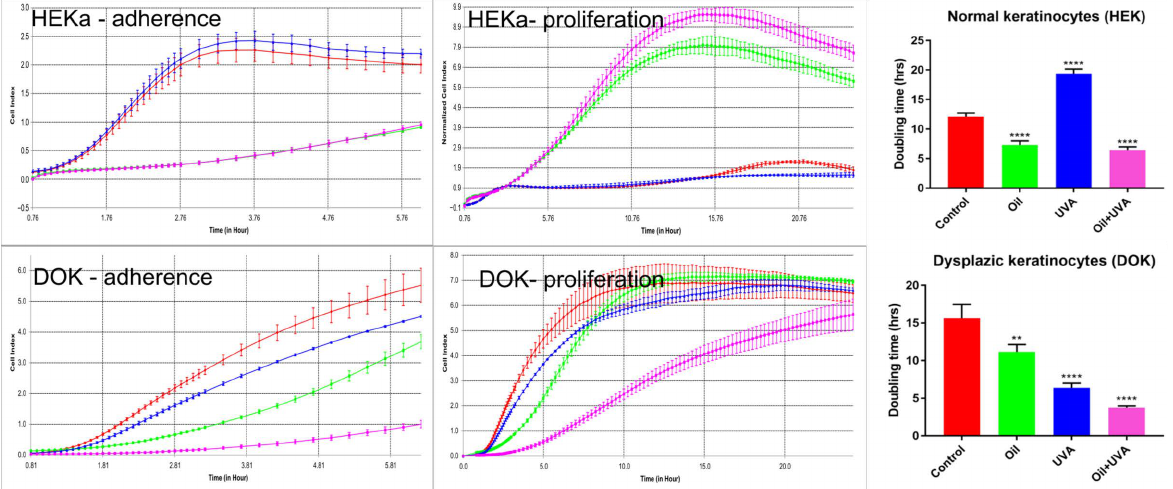
Figure 4. Cell adhesion and proliferation of normal and dysplastic keratinocytes, treated with sea-buckthorn seed oil, in the presence or absence of UVA irradiation. Each point on graphs represents the average cell index of triplicates, recorded every 15 min for 24 h. Bars represent average of triplicates with SD. One-Way Anova was used to assess statistical significance (** p < 0.01, **** p <